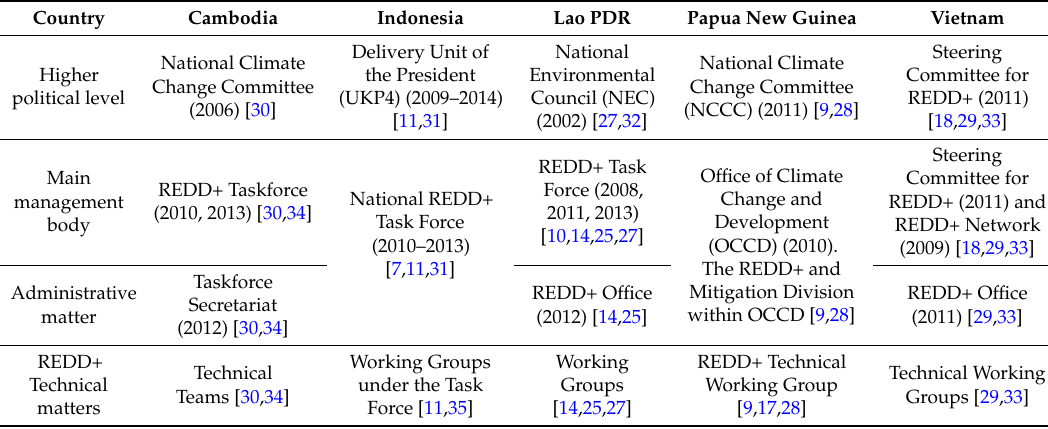
(year) is when the organization was established .